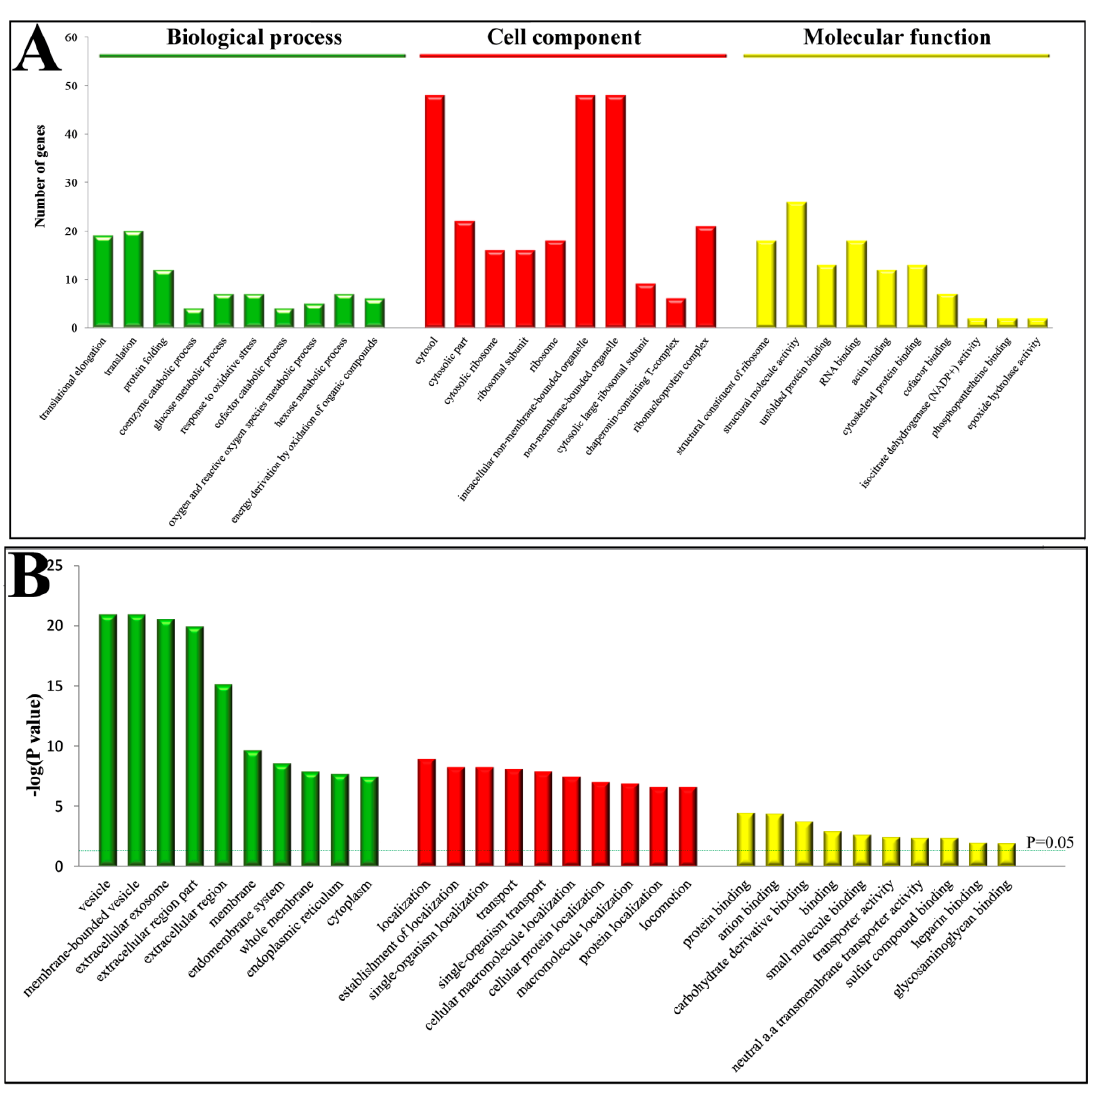
Figure 2. Gene ontology (GO) enrichment analysis of DEPs in the PPCs vs. FPCs. ( A ) Top 10 of each group were involved in “biological processes”, “molecular function” and “cellular component”. ( B ) p values of GO terms were indicated.